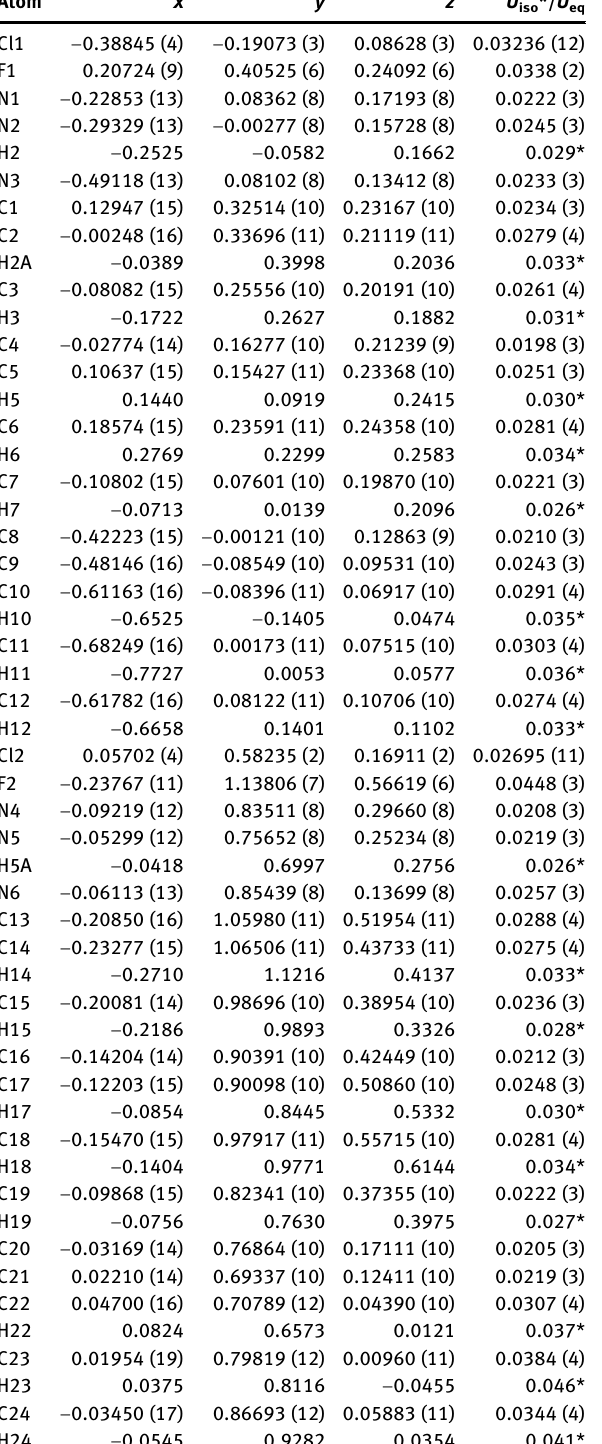
Table  : Fractional atomic coordinates and isotropic or equivalent isotropic displacement parameters (Å 